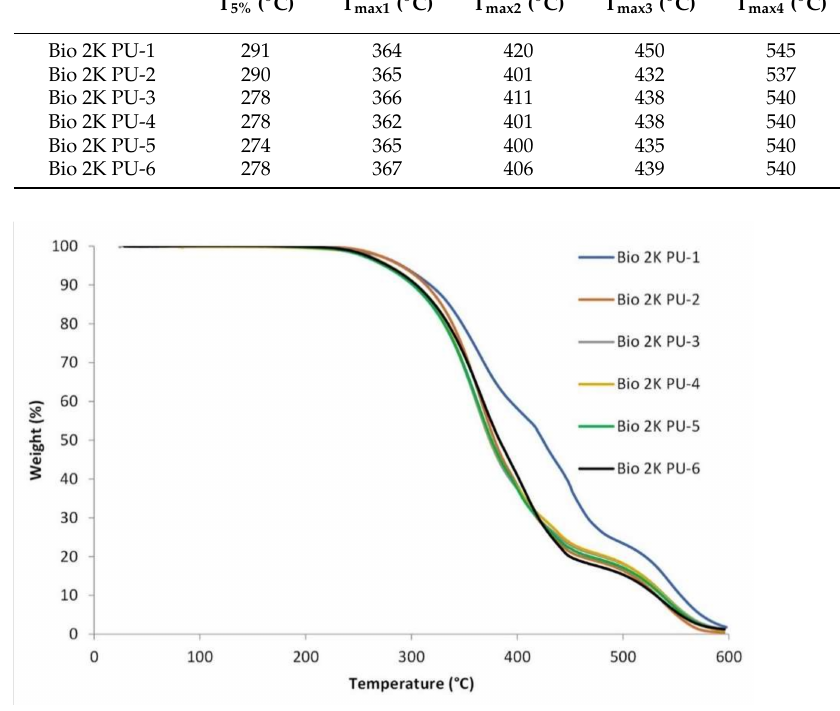
Figure 7. TGA curves of the bio-based 2K PU coatings in air. Derivative thermogravimetric (DTG) analysis revealed three degradation steps (Figure